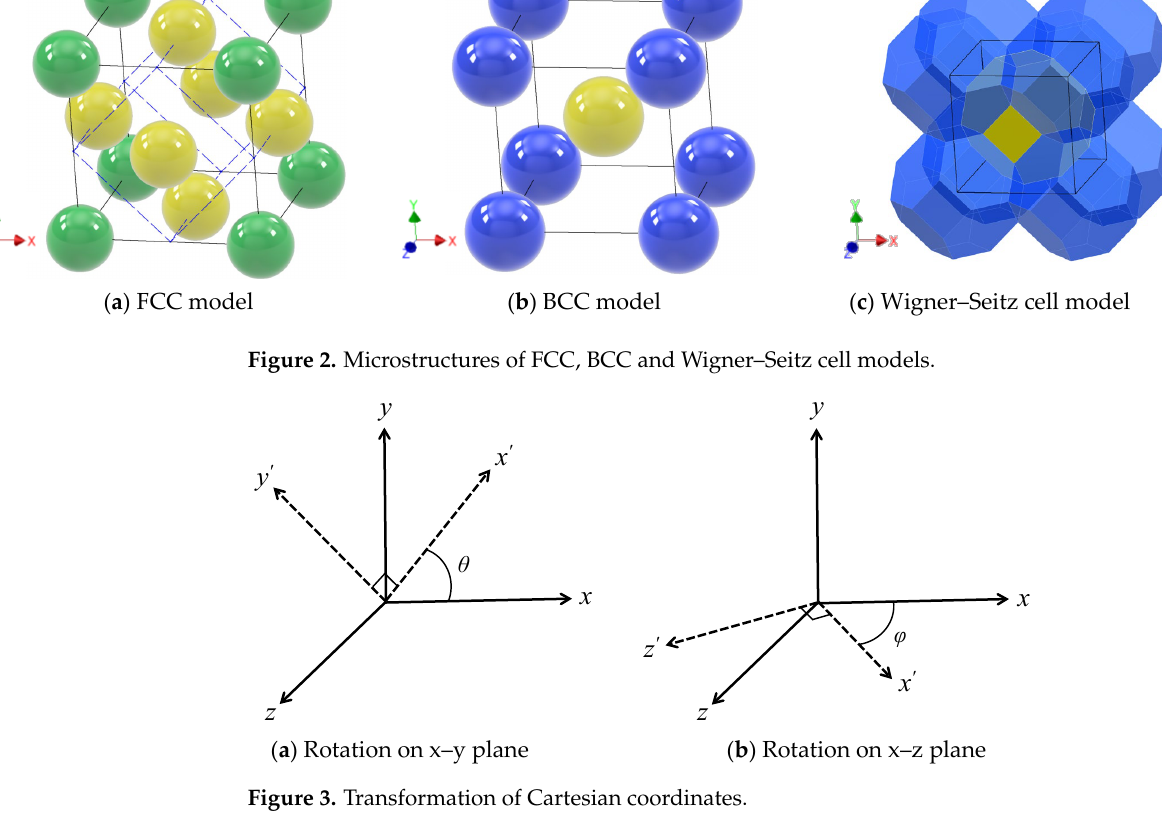
Figure 2. Microstructures of FCC, BCC and Wigner–Seitz cell models.